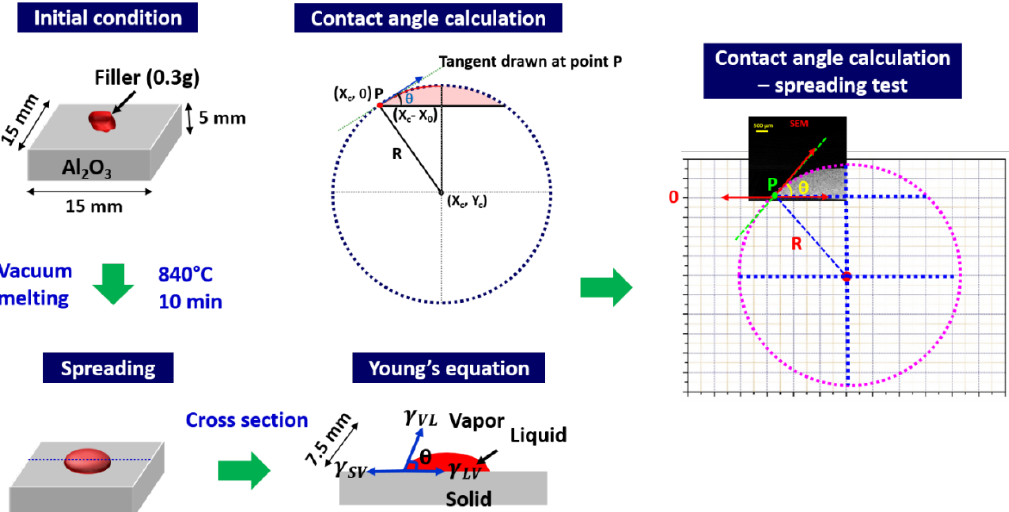
Figure 1. Schematic illustration of contact angle measurement after spreading.